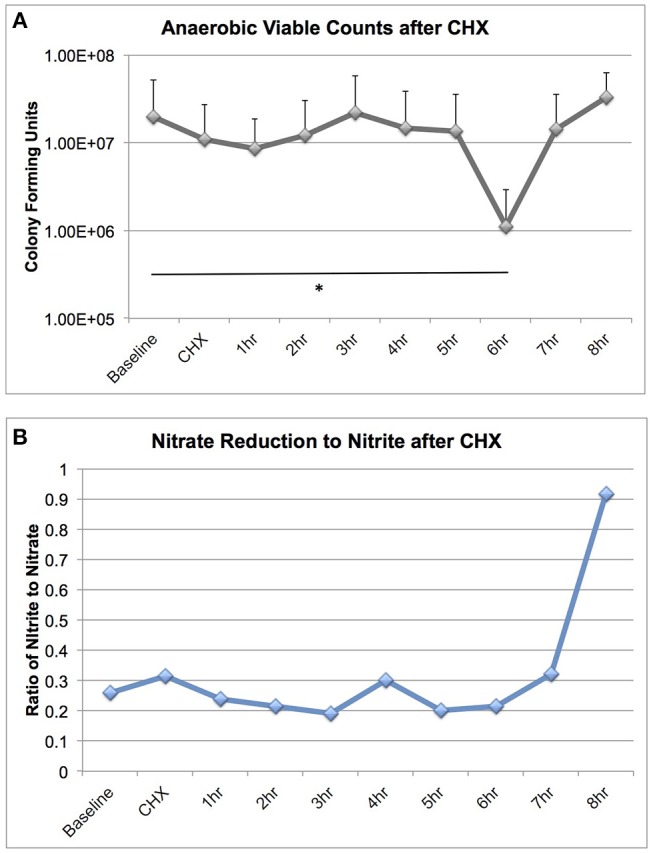
Bacterial viable counts and nitrate reductase activity recovered from tongue scrapings after CHX exposure. Six subjects collected tongue scraping samples over an 8 h time course after a 30 s rinse with 2% Peridex. Tongue samples were adjusted to a standardized starting OD600 and: (A) Serially diluted and plated for enumeration of viable counts on blood agar plates incubated anaerobically for 7 days and (B) Assessed for nitrate and nitrite values after anaerobic overnight incubation in 5 mM nitrate broth. Nitrate and nitrite results are shown as a ratio. Significant differences in viable counts between time points is indicated by an asterisk.